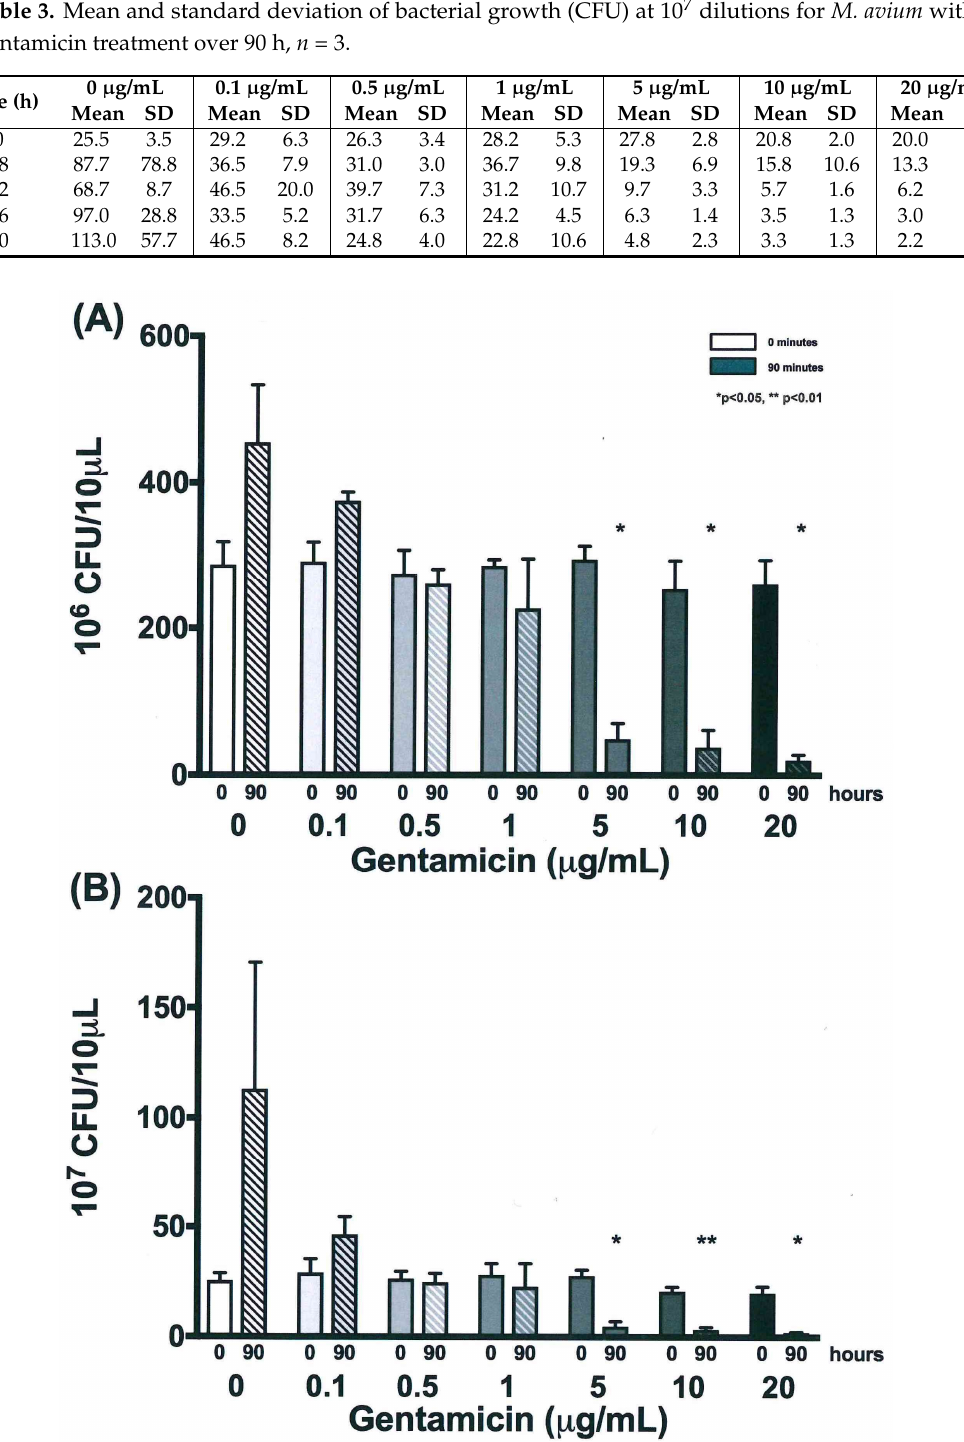
Figure 9. Growth of M. avium with gentamicin treatment at time zero and 90 h using colony forming units at ( A ) 10 −6 dilutions. Decreased CFUs after 90 h for 5, 10, and 20 µg/mL gentamicin treatments were significant at * p < 0.05 according to two-tailed, paired T -test analysis. M. avium treated with lower doses of gentamicin were not significant. ( B ) 10 −7 dilutions. Decreased CFUs after 90 h were significant for 5 and 20 µg/mL gentamicin treatments at * p < 0.05 and for 10 µg/mL gentamicin treatment at ** p < 0.01 according to two-tailed, paired T -test analysis. M. avium treated with lower doses of gentamicin were not significant, n = 3.